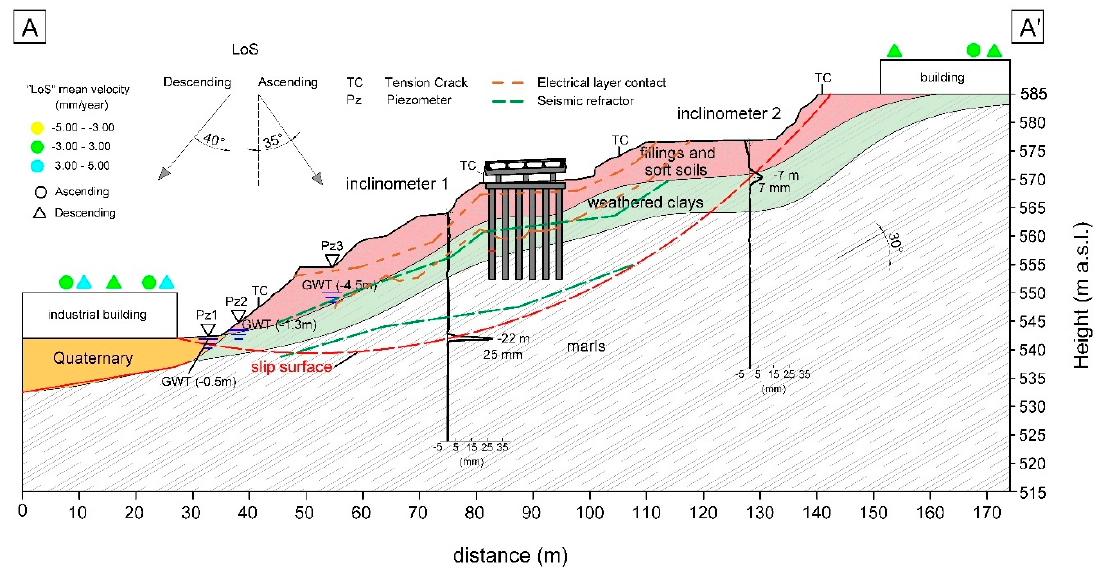
Figure 3. Integrated Cross ‐ section A ‐ A’ of the slope where Differential Interferometry Synthetic Aperture Radar (DinSAR) information, inclinometers and the potential slip surface have been included. Note that the plotted displacements correspond to the time period November 2012 to February 2013.